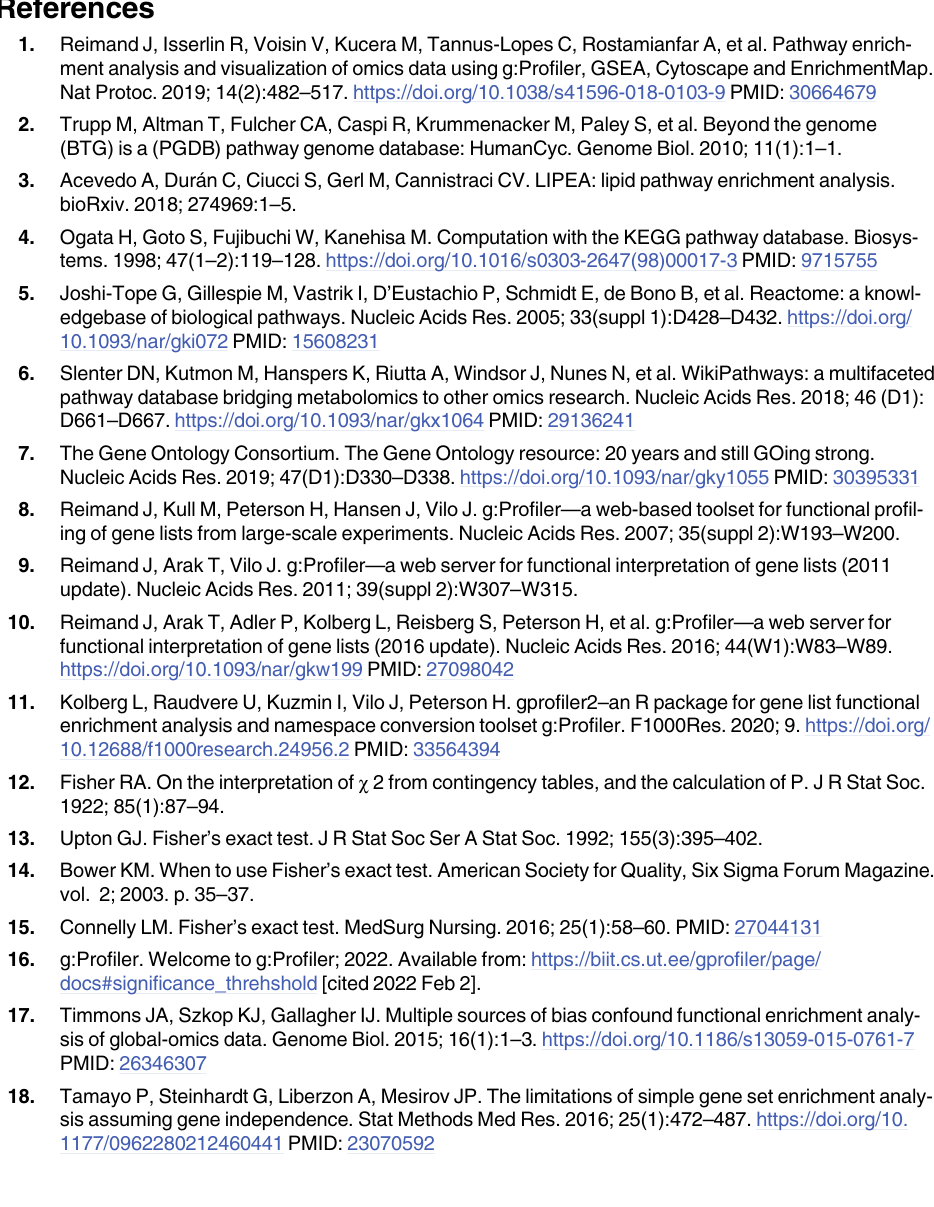
S1 Table. List of the PEA tools mentioned in this